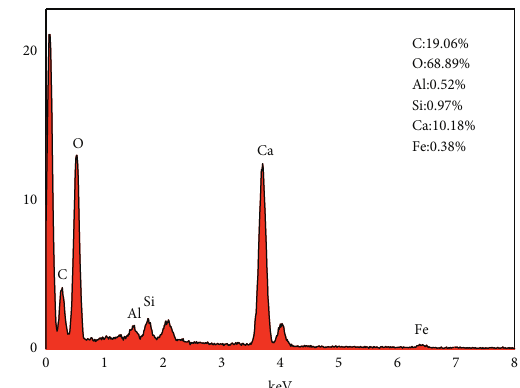
Figure 13: EDS spectrum of GO3 after 100 salt-frost cycles.